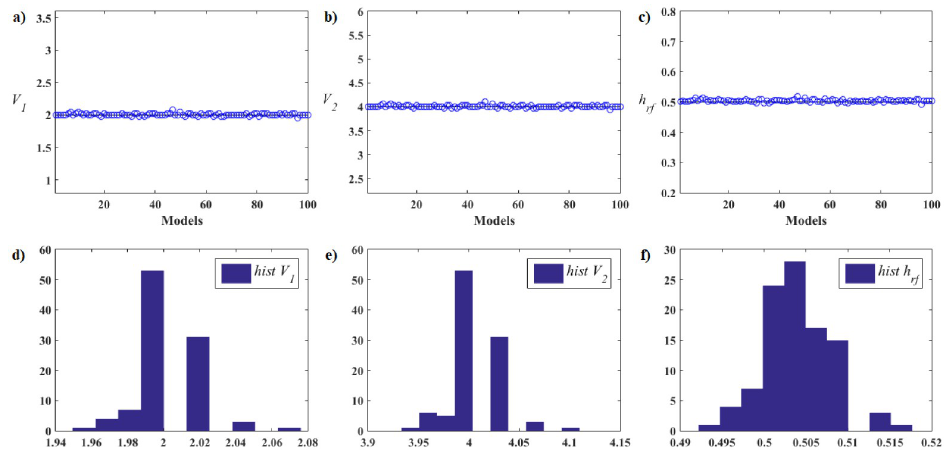
Fig 22. Case 1 (100 × 20). (a), (b), and (c) are all results obtained by the PSO-Kmeans-ANMS algorithm for variables V 1 , V 2 , and h rf , respectively. (d), (e), and (f) are their respective histograms.